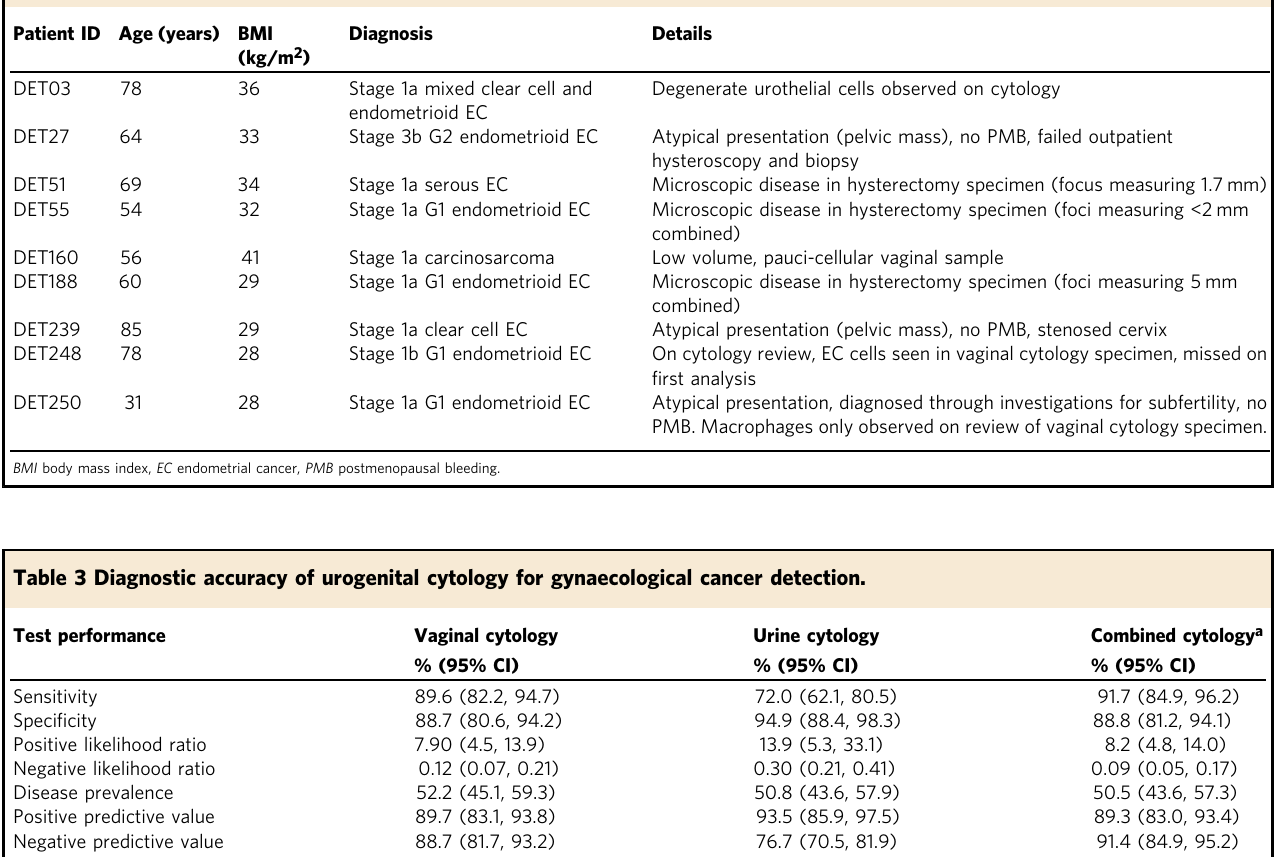
Table 2 Women with endometrial cancer in whom cytology was false negative.